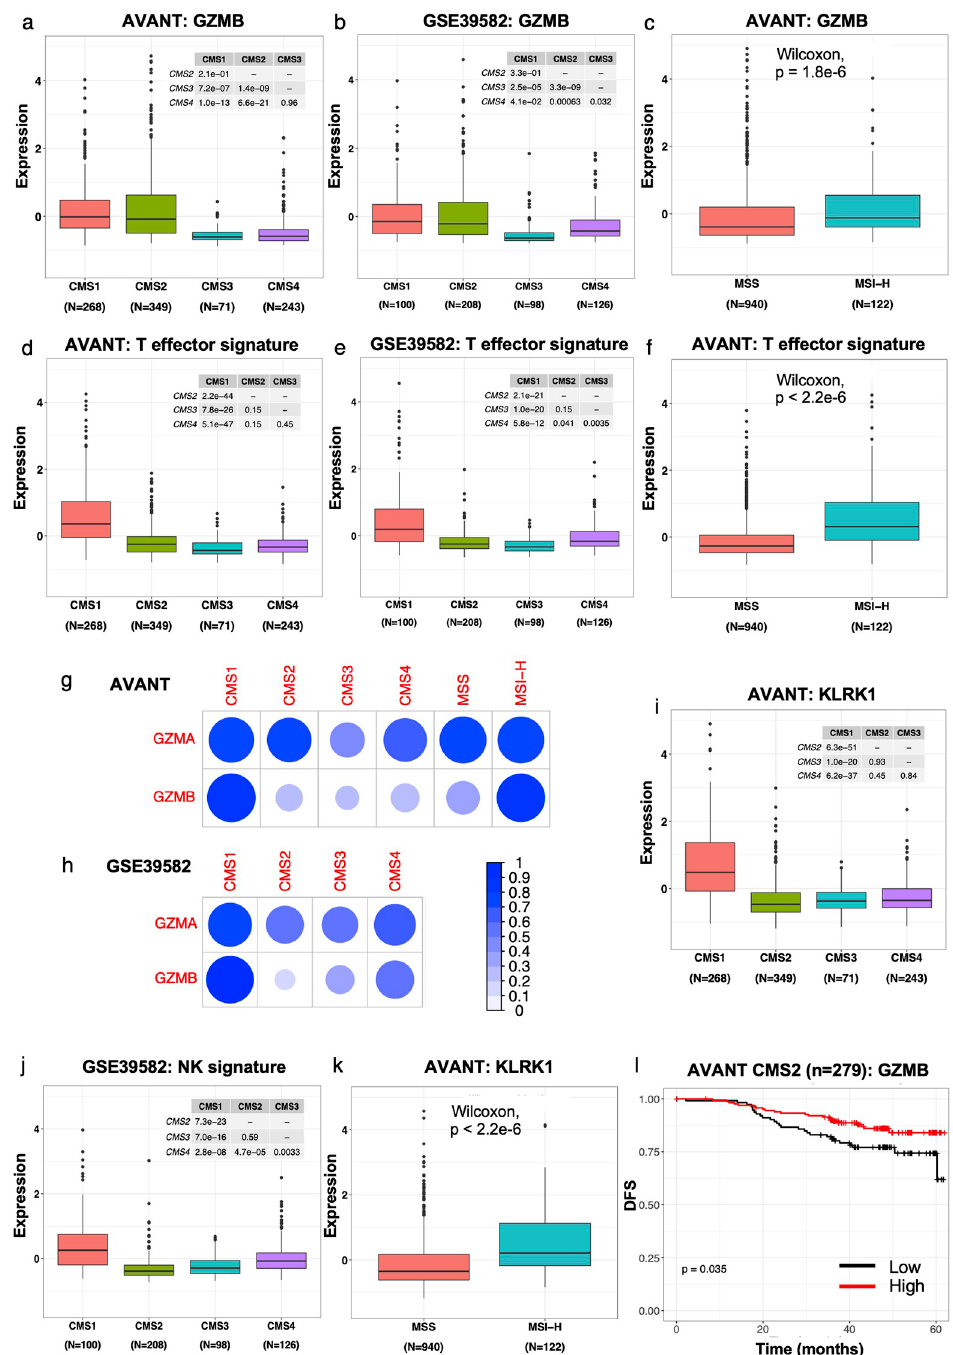
Fig 3. Immune cells are the source of GZMB in CMS1 CRC. (a-b) GZMB expression by CMS subtype in (a) the AVANT BEP dataset and (b) GSE39582. (c) GZMB expression by MSI status in the AVANT BEP dataset. (d-e) Expression of the T-effector signature by CMS subtype in (d) the AVANT BEP dataset and (e) GSE39582. (f) Expression of the T-effector signature by MSI status in the AVANT BEP dataset. (g) Pearson correlation between the modified T-effector signature (i.e. without GZMA/B) and GZMA or GZMB expression in AVANT patients, by CMS subtype or MSI status. (h) Pearson correlation between the modified T-effector signature and GZMA or GZMB expression in GSE39582 patients, by CMS subtype (MSI status was not available). (i) Expression of the NK cell marker KLRK1 by CMS subtype in the AVANT BEP dataset. (j) Expression of the NK signature by CMS subtype in the GSE39582 dataset. (k) Expression of the NK cell marker KLRK1 by MSI status in the AVANT BEP dataset. (l)